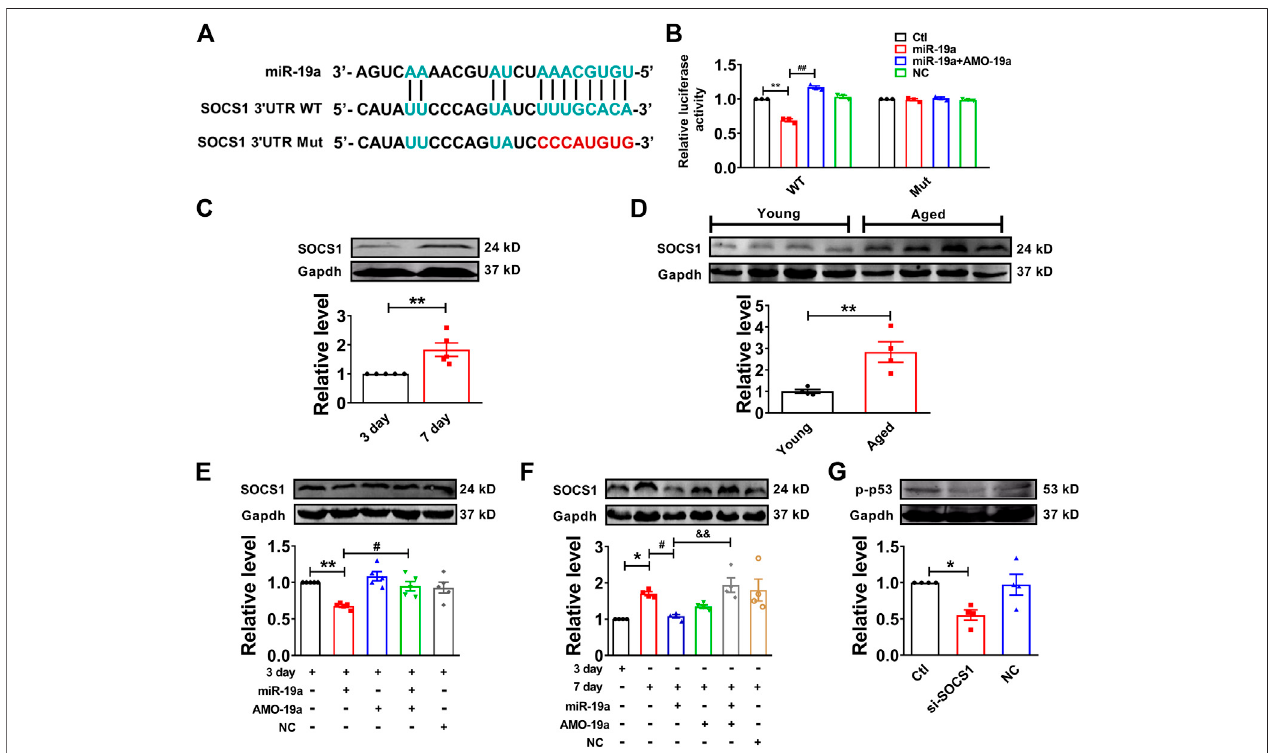
FIGURE 5 | miR-19a targets to SOCS1 mRNA in cardiomyocytes. (A) Sequence alignment showing the base-pairing between miR-19a and SOCS1. The complementary base pairs in SOCS1 3 ′ UTR and miR-19a are outlined in green; the mutated base pairs in SOCS1 3 ′ UTR are outlined in red. (B) miR-19a strongly inhibited the luciferase activity of reporter plasmid containing SOCS1 mRNA fragment compared with mutation group. (C) SOCS1 was increased in senescent cardiomyocytes. (D) SOCS1 was enhanced in aged mouse hearts. (E) The suppressive effect of miR-19a on the expression of senescence-associated protein SOCS1in cardiomyocytes at 3 days. (F) Aftertransfection with miR-19a mimic,theexpression ofSOCS1 decreasedcardiomyocytes at7 days. (G) Effect ofSOCS1 on the phosphorylation of p53 (p-p53). Data are expressed as mean ± SEM, * p < 0.05 vs. 3 days, ** p < 0.01 vs. 3 days, # p < 0.05 vs. 7 days, ## p < 0.01 vs. 3 days + miR- 19a, & p < 0.05 vs. 7 days + miR-19a + AMO-19a, n (cid:2) 5 –